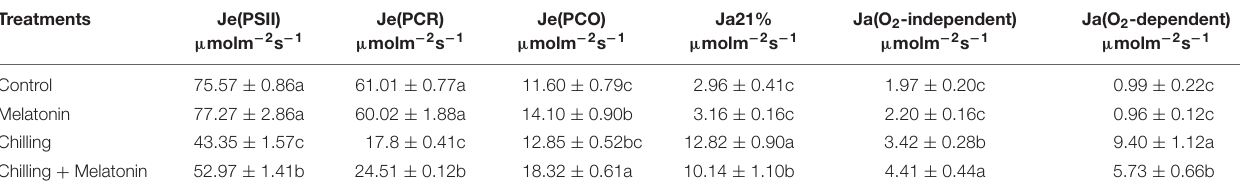
TABLE 1 | Effects of exogenous melatonin on photosynthetic electron partitions after four days chilling stress.